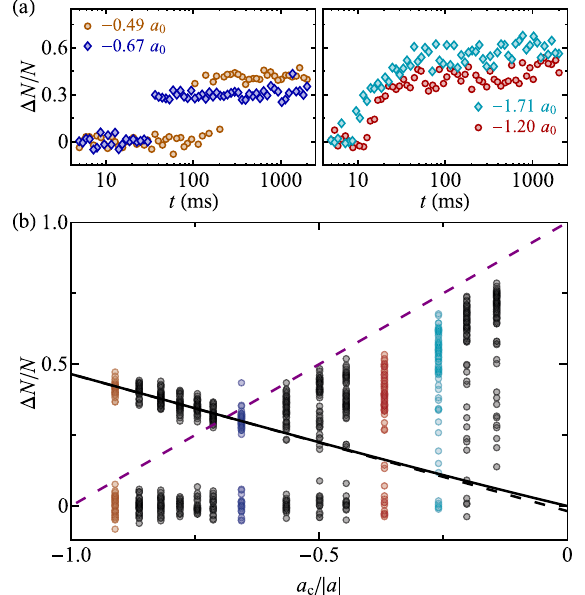
FIG. 5. Weak-collapse scaling laws. (a) Writing Δ N=N ∝ j a j − γ for fixed L and N , for our six data sets we get an average FIG. 4. Observation of weak collapse. Here L ¼ 30 μ m and ¯ γ ¼ 1 . 02 ð 2 Þ . (b) Assuming Δ N=N ¼ C= j a j , we find C ∝ − 0 . 44 a N ¼ 20 . 3 × 10 4 , corresponding to a 0 . (a) Atom loss c ¼ N − 0 . 51 ð 2 Þ (solid black line), with no dependence on L . versus time after quenches to various a values. For small j a − a c j (left panel) Δ N=N decreases with increasing j a j , as expected for a (c) Universal behavior of the weak-collapse atom loss. We plot weak collapse, while for large j a − a (right panel) the opposite all the single-collapse data for different a , N , and L versus c j η 1 = 4 = j α j , which vanishes in the limit of infinitely strong attractive trend is seen. (b) Summary of atom loss for all t and a < a . The c colored points are the data shown in (a), and the points clustered interactions, j α j → ∞ . The linear fit gives Δ N=N ≈ 13 η 1 = 4 = j α j around Δ N ¼ 0 correspond to t < t . Single-collapse loss mono- c tonically decreases with increasing j a j and extrapolates to zero = j a j → 0 (dot-dashed and solid black lines, see text), for a c confirming the prediction of the weak-collapse theory. For a = j a j > − 0 . 6 single collapse does not re-stabilise the system c and multiple collapse occurs. The dashed purple line shows the =a (see text). equilibrium stability criterion, Δ N=N ¼ 1 − a c